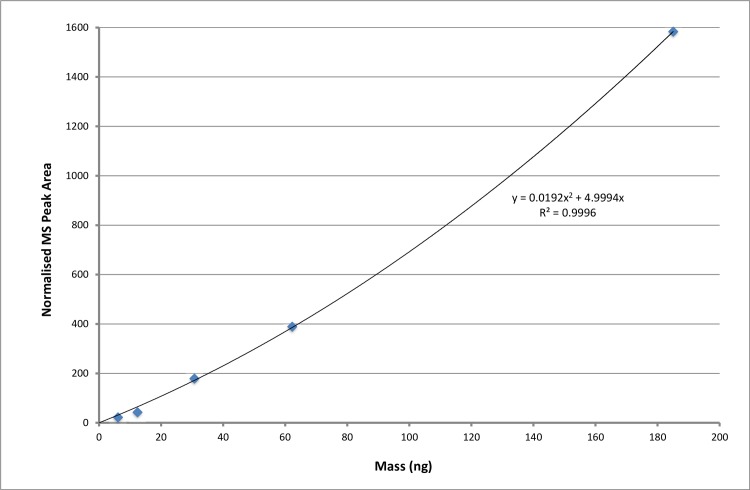
Calibration plot for 2-phenoxyethanol by automated thermal desorption gas chromatography mass spectrometry.